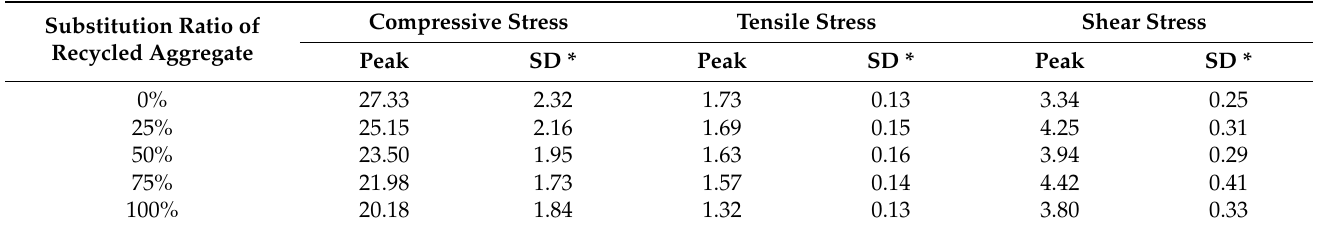
Table 3. Peak compressive, tensile, and shear stresses of recycled aggregate concrete with different substitution ratios (unit: